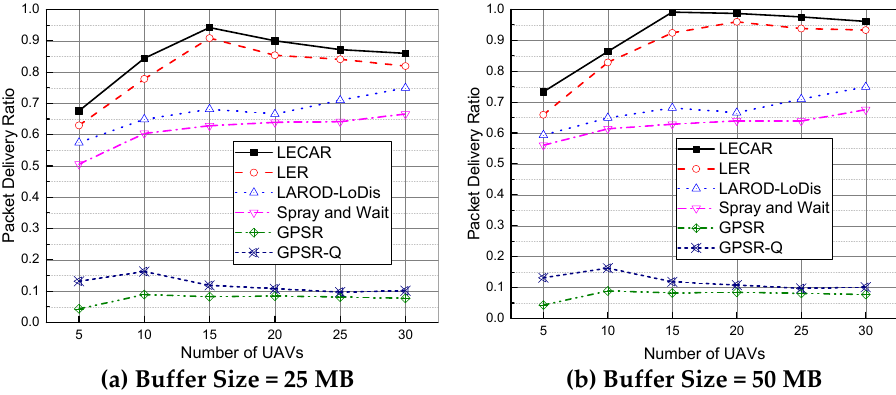
Figure 11. Performance comparison of routing protocols for the packet delivery ratio when the buffer size is ( a ) 25 MB and ( b ) 50 MB.